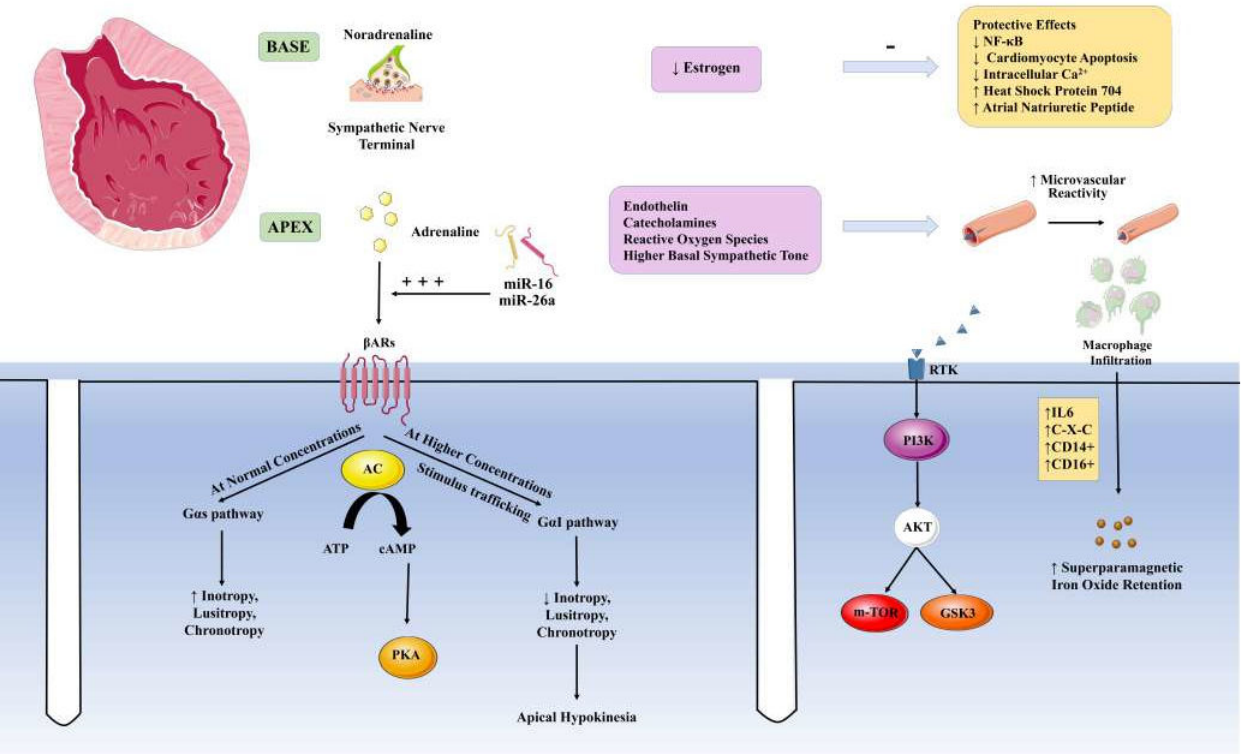
Figure 2. Molecular mechanisms for Broken Heart Syndrome. Parts of the figure were drawn using pictures from Servier Medical Art (smart.servier.com) [accessed on 2 November 2022], pro- vided by Servier, licensed under a Creative Commons Attribution 3.0 unported license. (https: